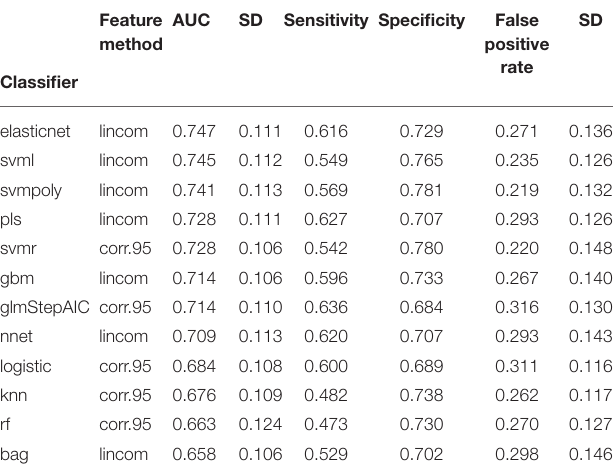
TABLE 4 | AUC values for classifiers with highest predictive performance (SD taken over the 50 cross-validation testing